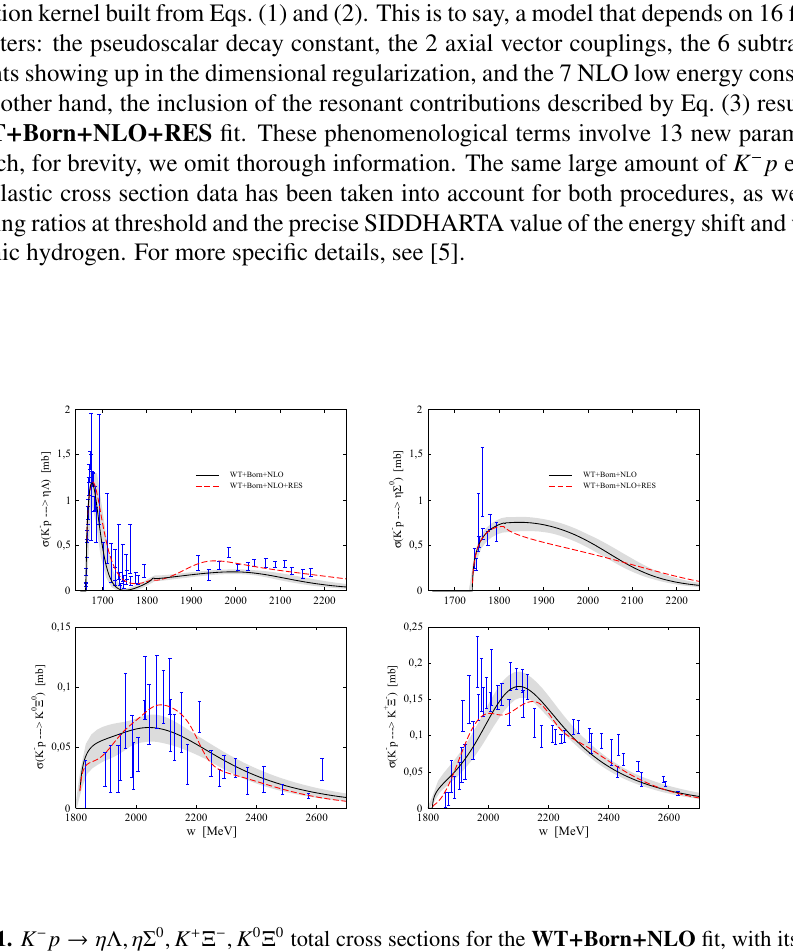
, defined in [2], for both fits. d . o . f .